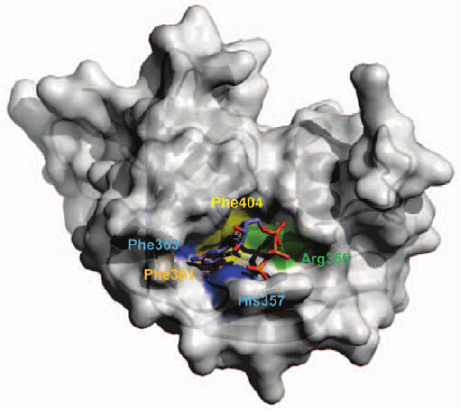
Figure 4. The cap-binding pockets for the influenza A virus PB2 subunit. The residues around the cap-binding pocket are colored so that those aromatic amino acids forming the cap sandwich around the cap analogue m7GTP are in blue, those binding the functional groups of the guanine residue are in orange, those stabilizing the 7-methyl group are in yellow and those binding the triphosphate moiety are green.